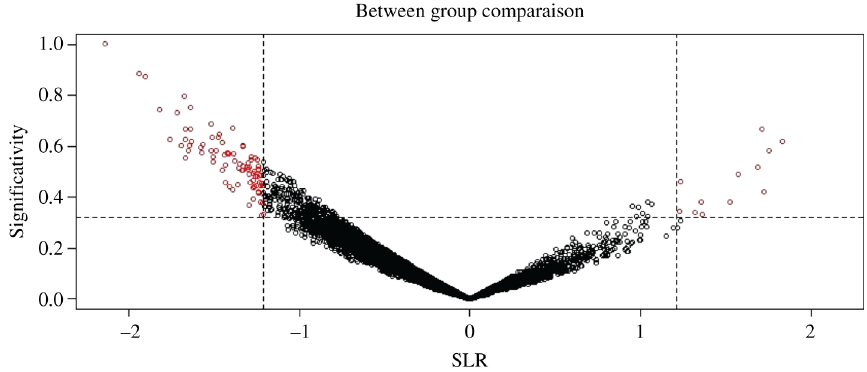
Figure 9: Linear models for GSE2443.